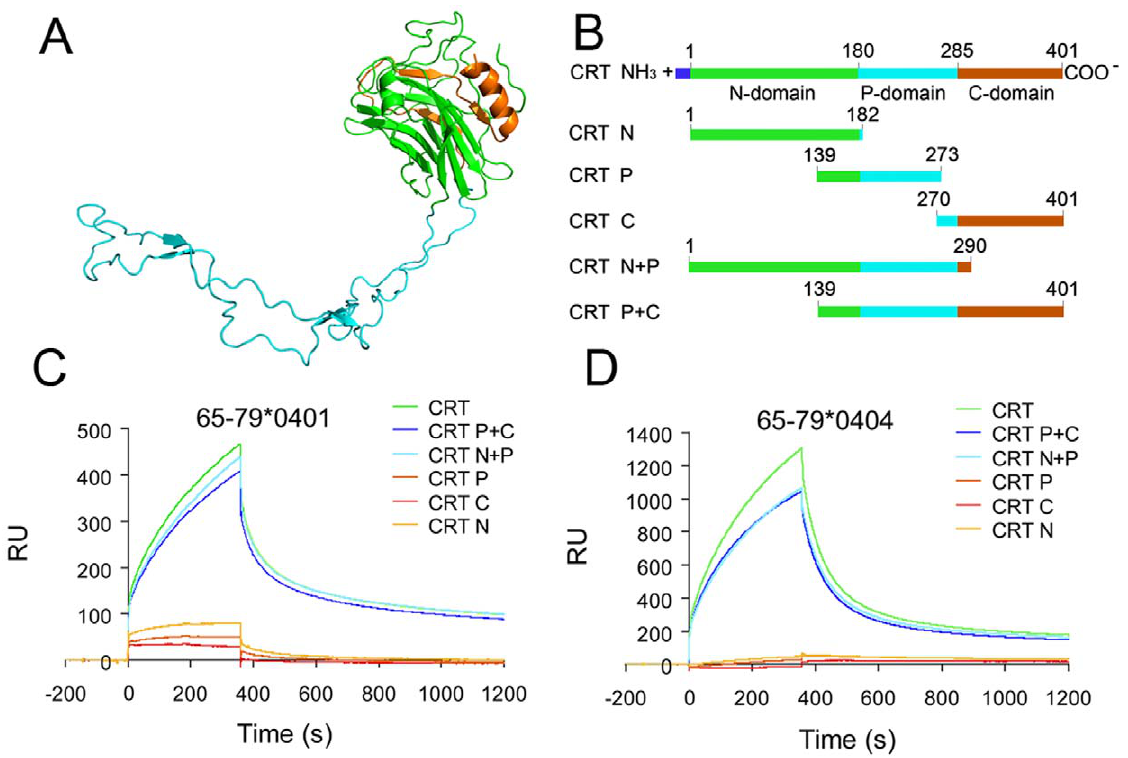
Figure 1. Interaction between the SE and domain-deleted CRT. A. A theoretical 3D structure of CRT. Rabbit CRT (Accession No. AAB20096) was computationally modeled based on the known crystal structure of Calnexin (PDB ID: 1JHN), using Modeler 9v7 software (School of Pharmacy, UCSF). CRT N-domain is shown in green, P-domain is in cyan and C-domain is shown in orange. B . Schematic representation of rabbit CRT domain- deletion mutants. C,D. SPR-based interactions between the SE ligand and CRT domain-deletion mutants. WT CRT or its domain-deletion mutants were immobilized on a CM5 biosensor chip surface and the SE peptidic ligands 65-79*0401 ( C ) or 65-79*0404 ( D ) were run in the analyte.